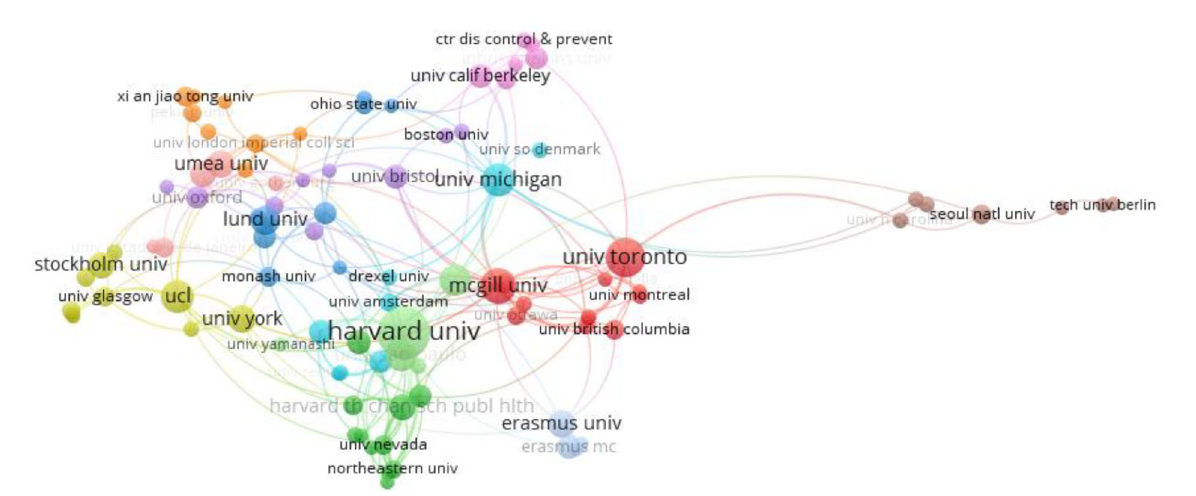
FIGURE5 Cooperation between institution.